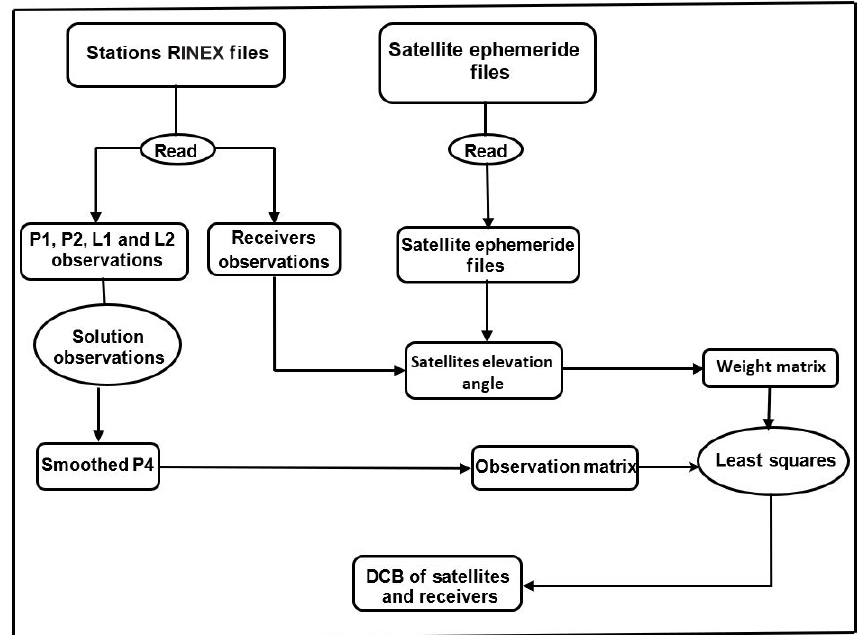
Figure 1. The flowchart shows how the code works.